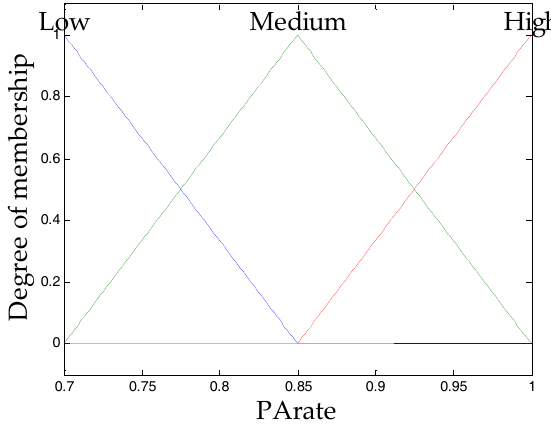
Figure 4. Output of Fuzzy System 2: PArate (Pitch Adjustment Parameter).